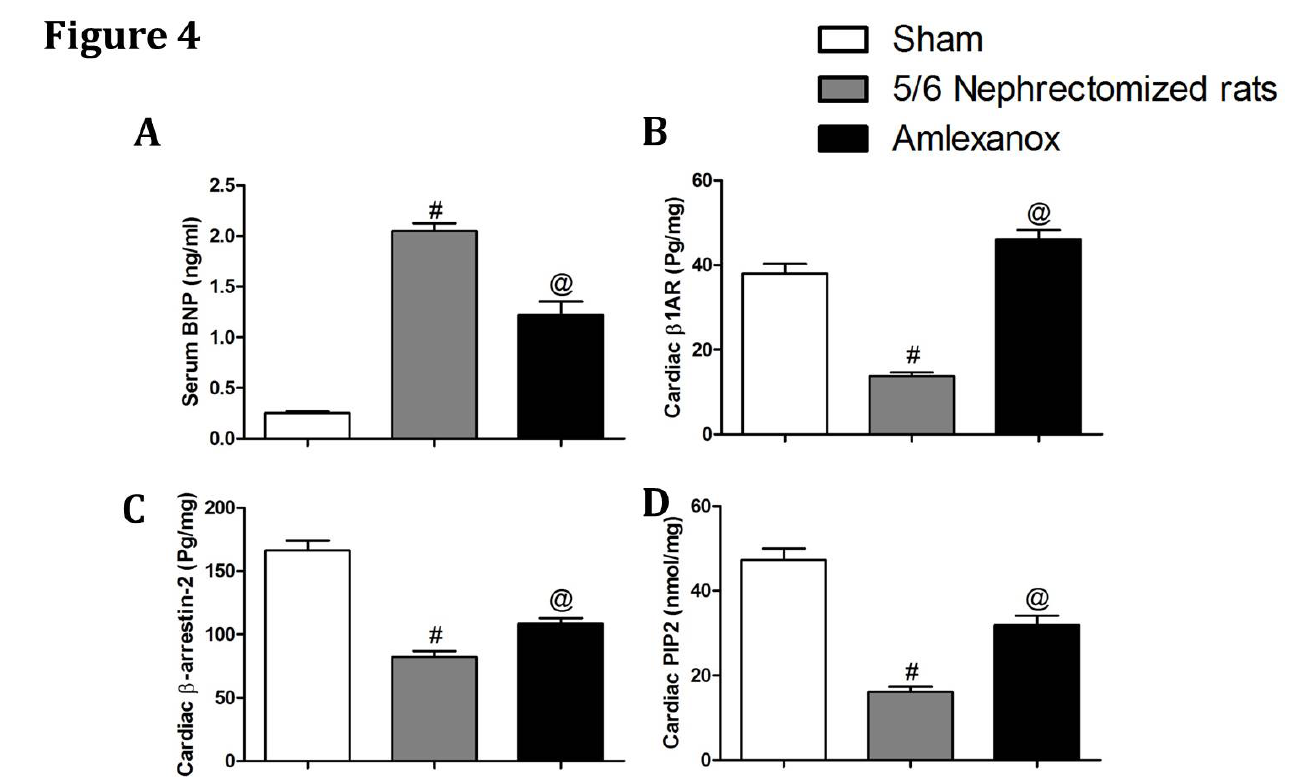
FIGURE 4 - Changes in serum brain natriuretic peptide (BNP) and cardiac adrenergic signaling pathways. (A) Quantitative analysis of serum BNP. (B) Quantitative analysis of β1-adrenergic receptor β1AR. (C) Quantitative analysis of β-arrestin-2. (D ) Quantitative analysis of phosphatidylinositol-4,5-bisphosphate (PIP2). Amlexanox (25 mg/kg/day) was injected i.p. for 10 weeks, starting just after 5/6 nephrectomy. Groups were compared using one-way ANOVA and post-hoc Tukey’s test. Values are represented as mean ± SE (n = 6). #P < 0.05 compared with the sham group, @P < 0.05 compared with the 5/6 nephrectomy